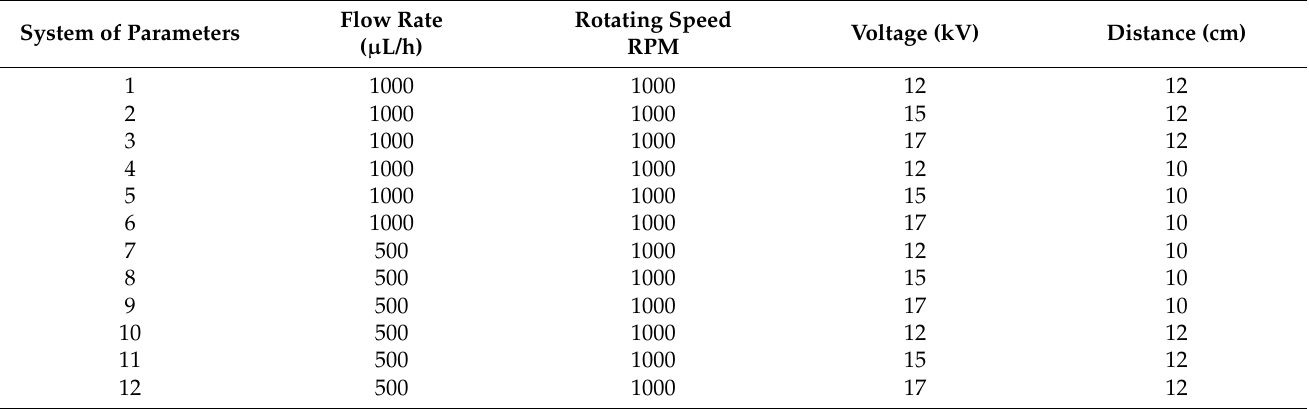
Figure 2. Setup of the electrospinning process and examined parameters. Table 2. Set of parameters of the electrospinning process for the preparation of the PCL electrospun nanofibrous matrices.